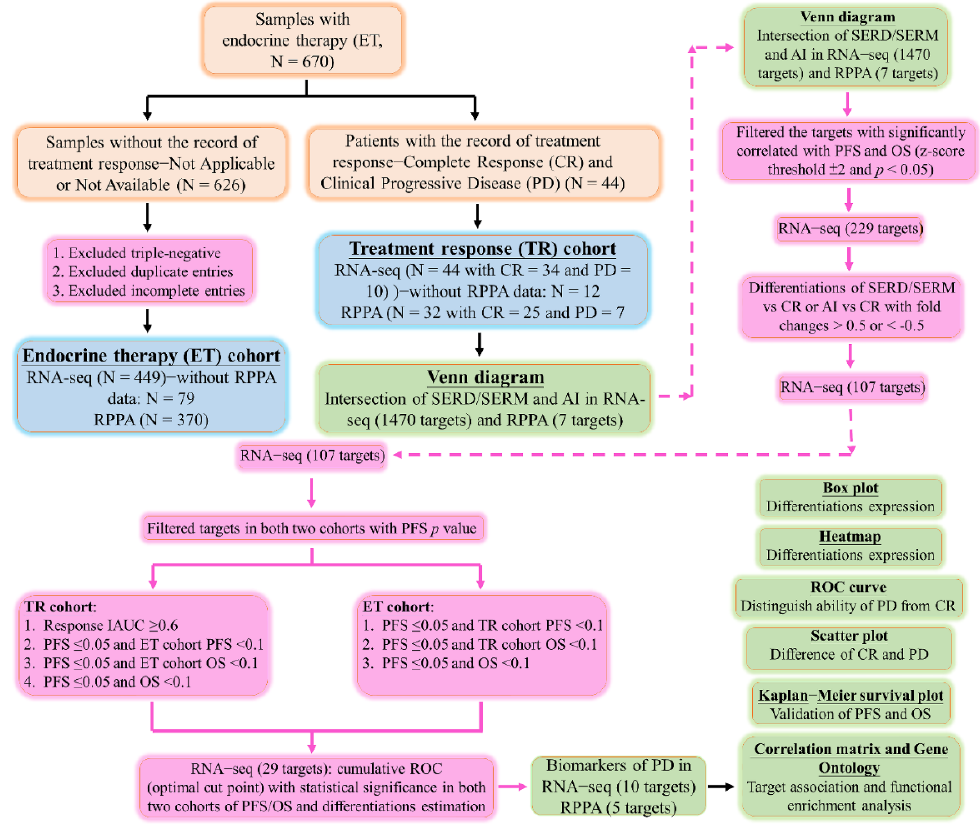
Figure 1. The workflow of the study. The 29 targets from RNA-seq and seven targets from RPPA were calculated based on optimal cut-off points and individual receiving operating characteristics (ROC)